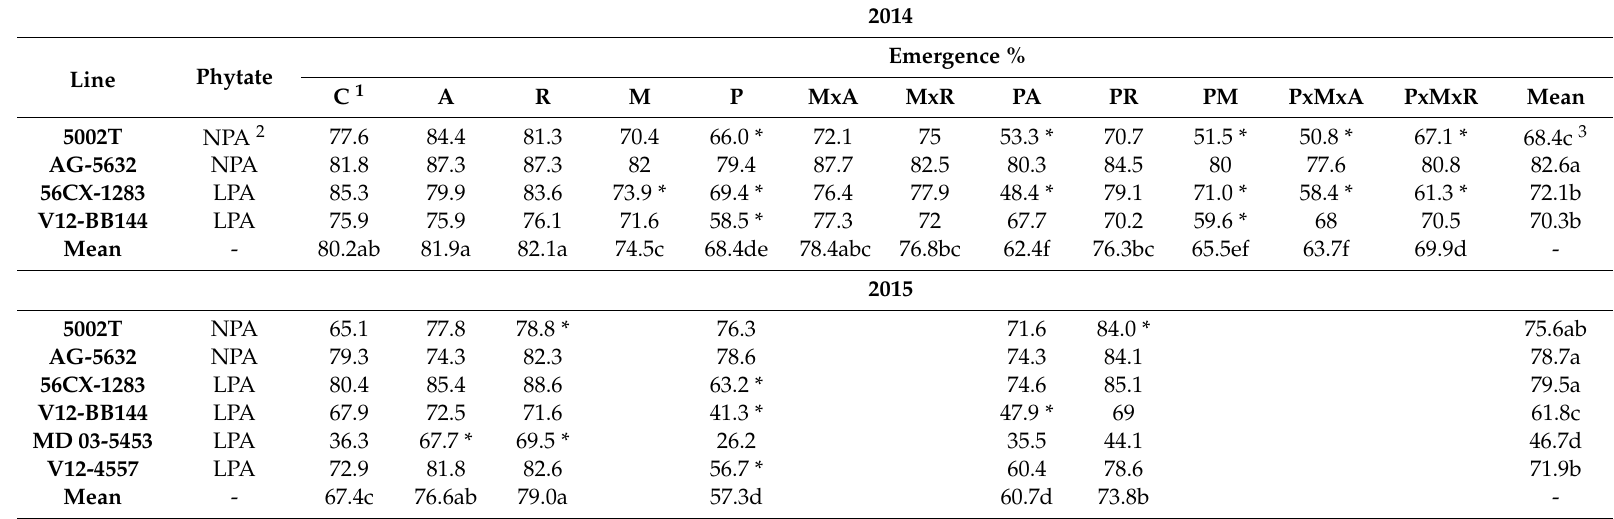
Table 5. E ff ects of seed treatments on field emergence in NPA and LPA soybeans and Tukey’s separation of means in 2014 and